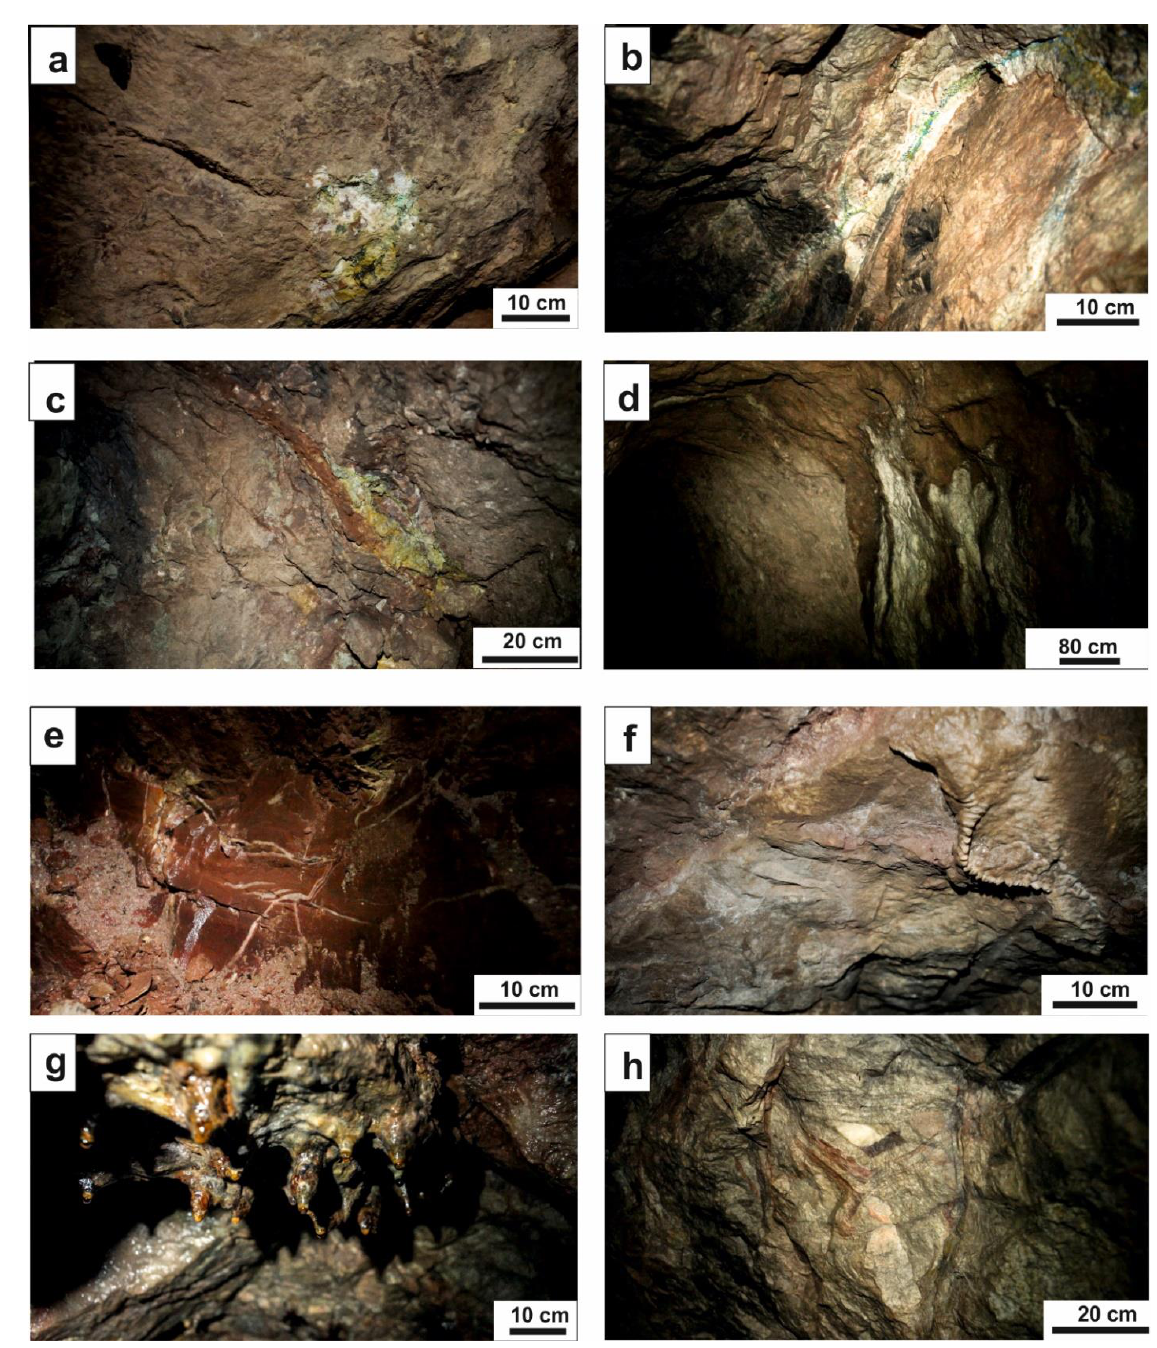
Figure 6. Underground photos showing various styles of mineralization and morphological features in the Teresa adit: ( a ) nest of malachite (green color) and azurite (blue color) mineralization, 20 cm wide, between sites P1 and P3; ( b ) calcite vein with malachite (green color) and azurite (blue color) mineralization, 5 cm wide, near site P4; ( c ) vein filled with malachite and Fe oxide secondary minerals after primary Cu-Fe sulfide (chalcopyrite) ore minerals, 12 cm wide near site P3; ( d ) infiltrates of white calcite on the wall of an underground gallery, near site P2; ( e ) Fe oxide or hydroxide minerals flowstone on the wall, between sites P1 and P3; ( f ) white calcite stalactites in natural parts (caves) of the Teresa adit, site P1; ( g ) red stalactites of a mixture of calcite and Fe oxide minerals in natural parts (caves) of the Teresa adit, site P4; and ( h ) tectonic zone within limestones with visible tectonic breccia cut by Fe oxide mineral veins, near site P4.